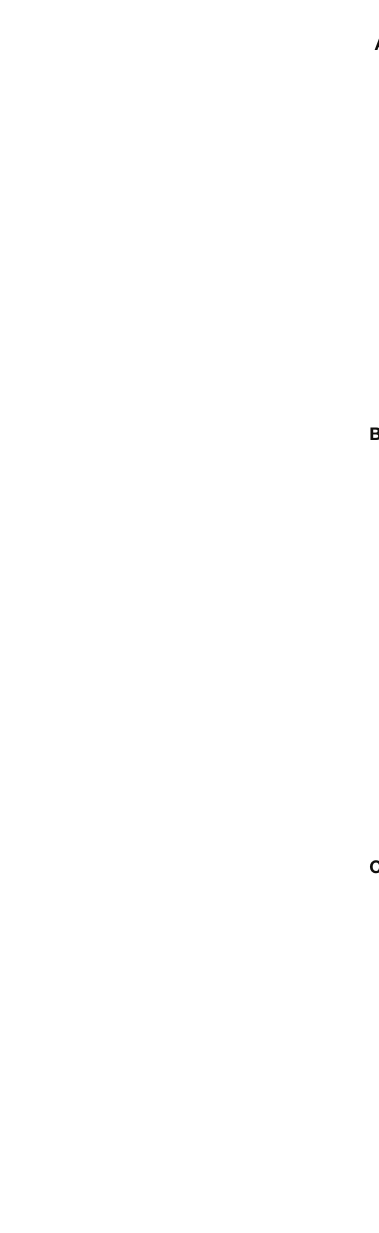
FIGURE 4 Analysis of amylase release, glucose uptake and inhibition of AGEs in presence of Madhugrit. (A) The release of amylase in dexamethasone differentiated AR42J cells was performed after induction with starch (1% w/v) in presence of Madhugrit. Undifferentiated cells (UDC) were taken as a normal control. (B) The uptake of glucose post Madhugrit treatment was evaluated in L6 myotubes by the fl uorescent glucose analog 2- NBDG. (C) Evaluation of inhibitory potential of Madhugrit against AGEs formation. The statistical signi fi cance of the observed differences in the means compared to the Madhugrit (0 µg/ml) group was analyzed through one-way ANOVA followed by Dunnett ’ s multiple comparison test and represented as *, ** or *** depending on whether the calculated p value was <0.05, <0.01 or